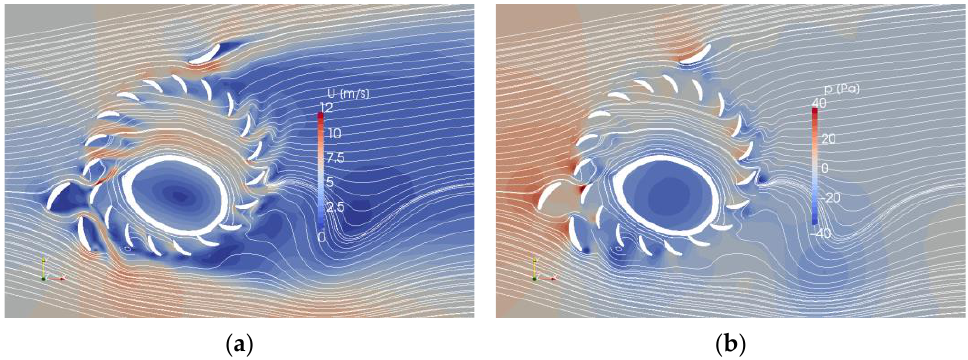
Figure 16. Velocity and pressure distribution and streamlines of the cross-flow wind turbine with TFD of inclination angle θ = +15 deg., ( a ) velocity distribution, U ; ( b ) pressure distribution, p .